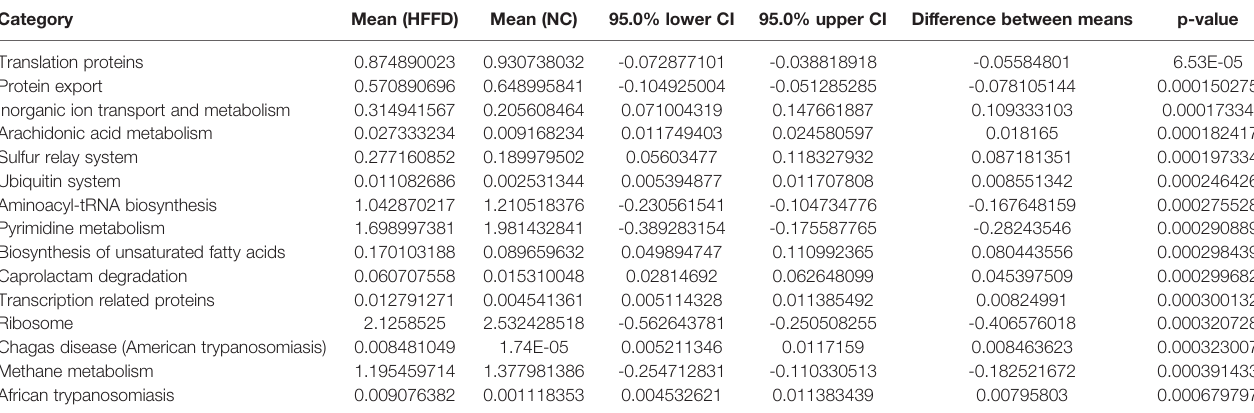
TABLE 5 | PICRUSt predicted results (Top 15) of NC vs. HFFD. Category Translation proteins